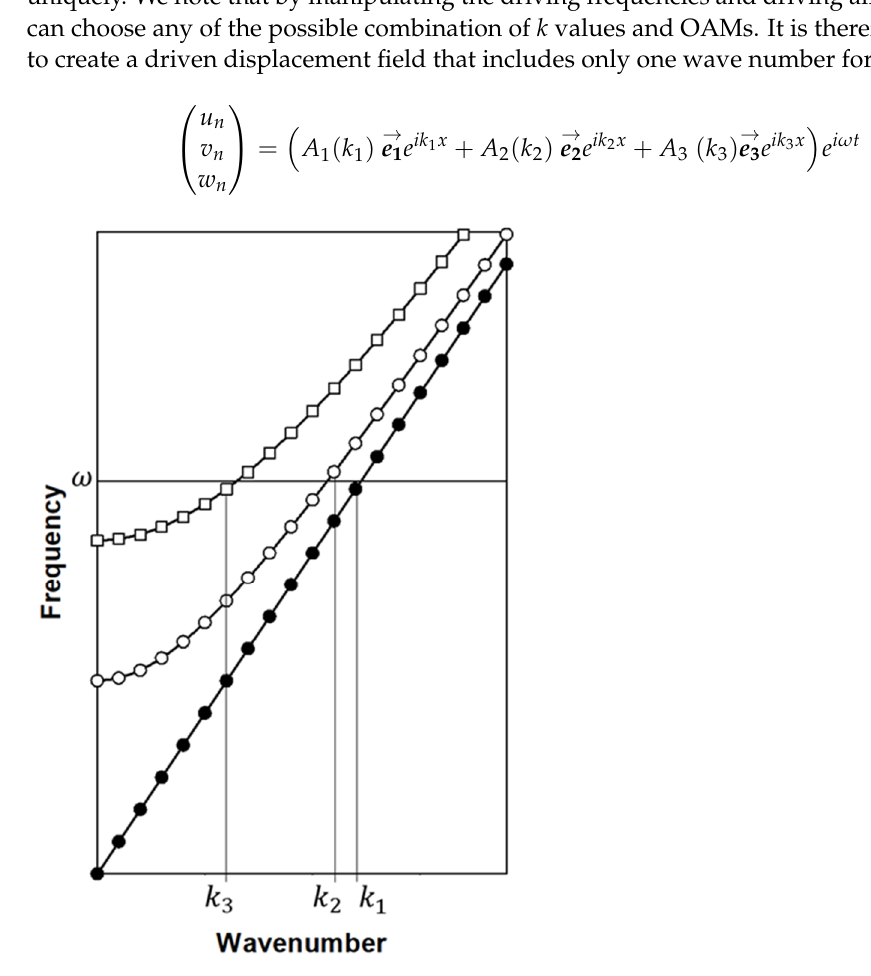
Figure 2. Illustration of the dispersion relation for the three elastically coupled waveguides. The value ω is the driving frequency of the driving force. The wavenumber of the modes with the largest amplitudes at ω has been highlighted on the x-axis. Since the amplitudes for each state are Lorentzian, states farther away from the driving frequency will have smaller amplitude.